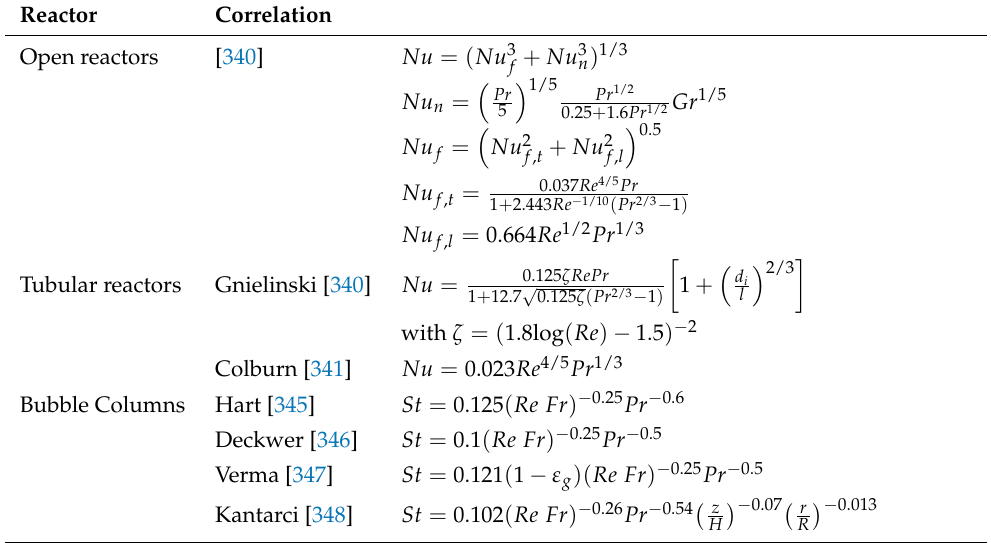
Table 15. Heat transfer coefficient